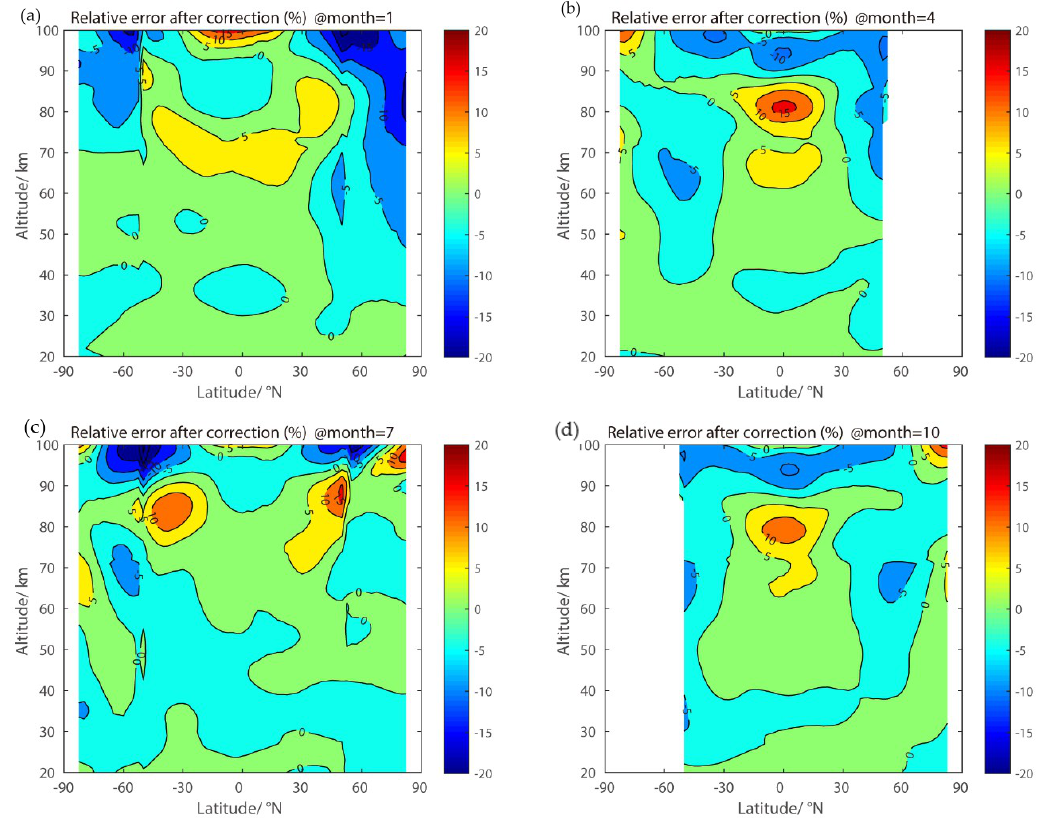
Figure 4. Same as Figure 2 but for zonal mean relative difference between NRLMSISE-00 and TIMED/SABER density after correction in ( a ) January, ( b ) April, ( c ) July, ( d ) October.